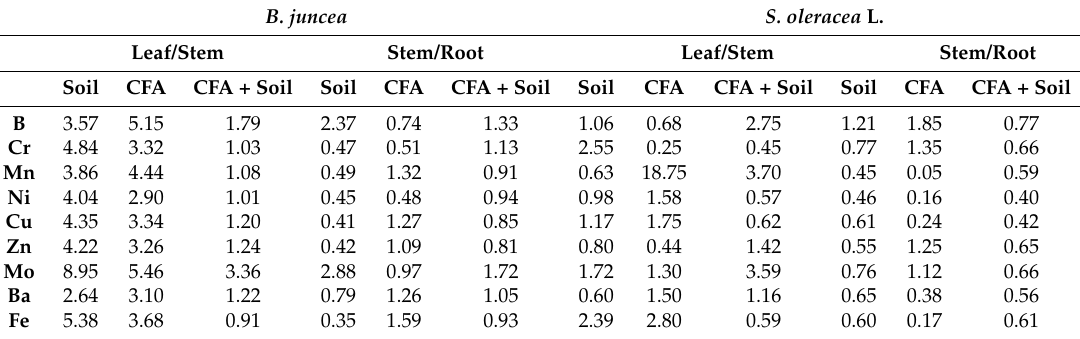
Table 4. Translocation Factor (TF) of various chemical species for 115 days in different species of plants grown in different growth media. TF = BCFb/BCFc, i.e., stem/root, and TF = BCFa/BCFb, i.e.,